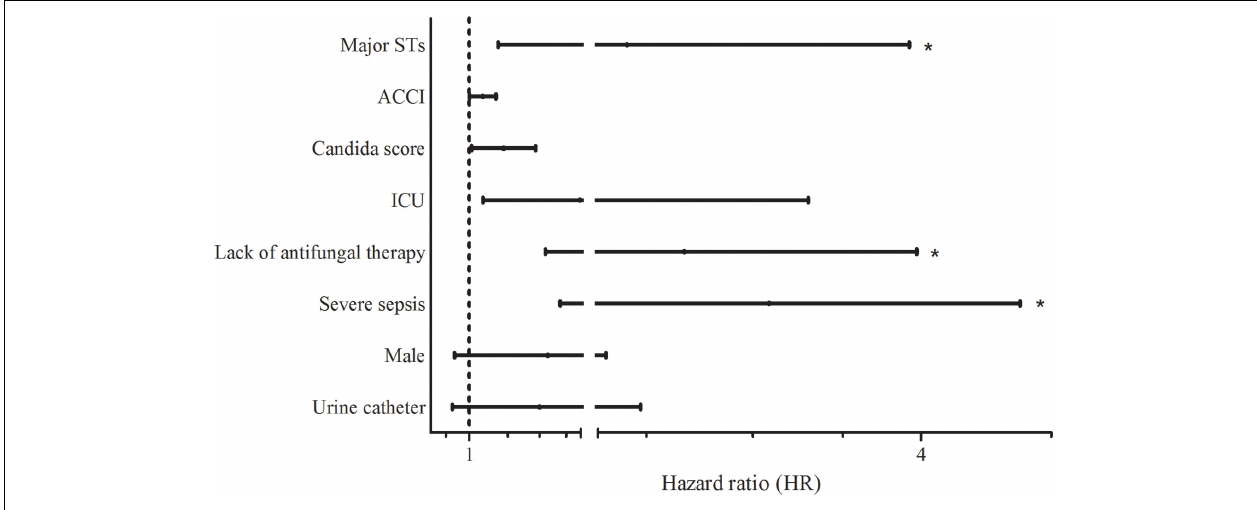
FIGURE 1 | Hazard ratios (HRs) for 30-day mortality according to various factors. Lines indicate HRs and their 95% confidence intervals (CIs) for all variables suggested as prognostic factors for 30-day mortality by univariate analysis ( p < 0.1) ( Table 4 ). Asterisks indicate p < 0.05 in adjusted HRs. Abbreviations: Major STs, major sequence types (ST7 or ST3) by multilocus sequence typing (MLST; ACCI, age-adjusted Charlson comorbidity index; ICU, intensive care unit.